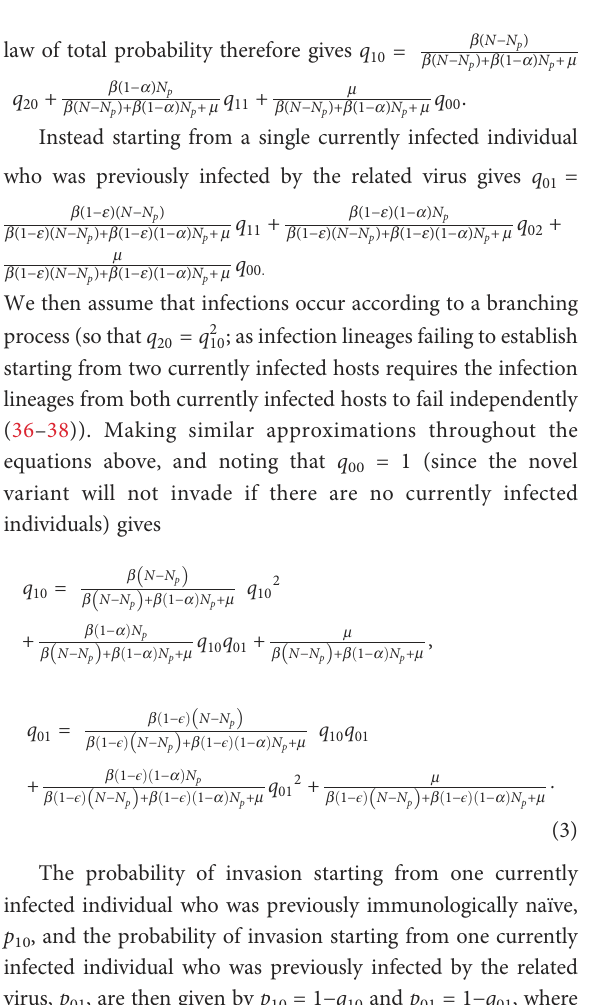
TABLE 1 Illustrative parameter values used in model simulations. Parameter Meaning N Size of local host population 1/ g Mean latent period of novel variant Mean infectious period of novel